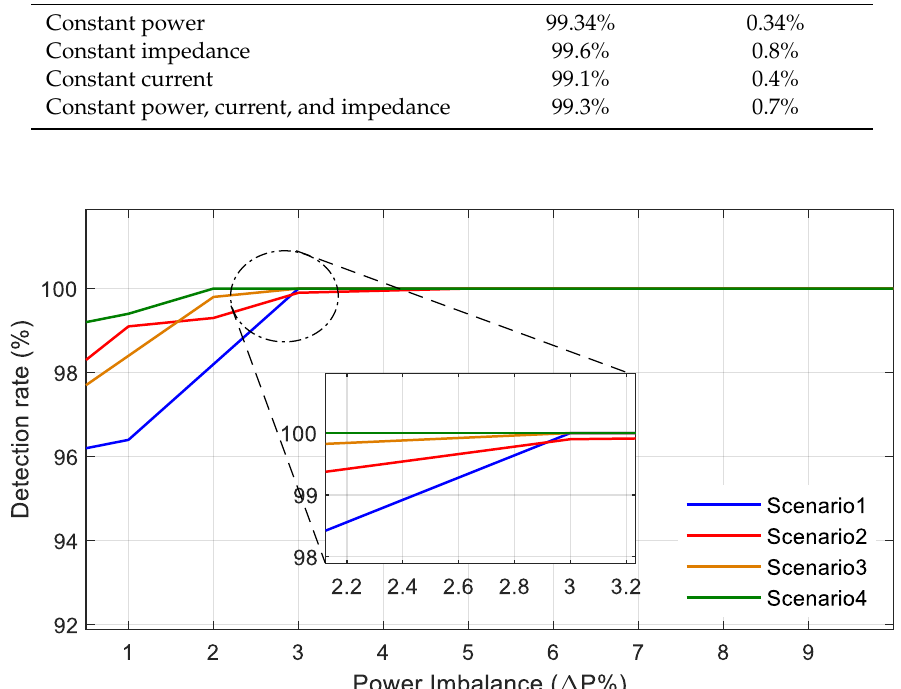
Figure 10. Detection rate of the classifier for power imbalance in different scenarios. Table 7. Results for testing of different power imbalances with the trained SVM.